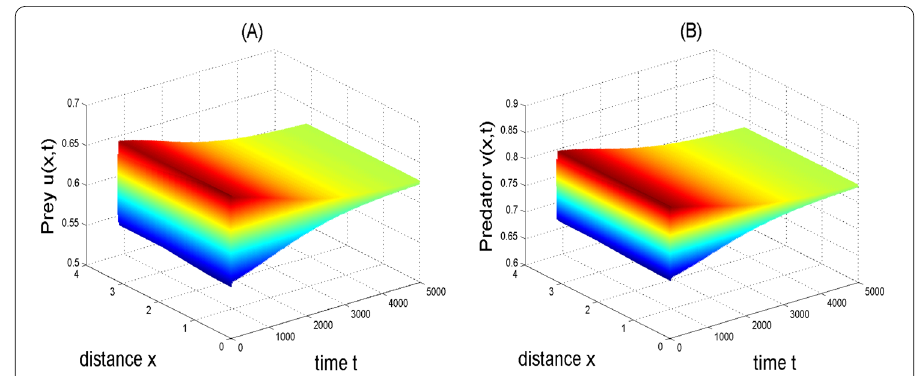
Figure 1 The positive equilibrium ( u ∗ , v ∗ ) = (0.6250,0.7813) of (1.2) is asymptotically stable when τ = 6.5 < 6.8222. Here we set parameter values d 1 = 0.2, d 2 = 1, δ = 2, α = 0.05, β = 0.3, h = 0.8, c = 0.1 and the initial value ( u ( x ,0), v ( x ,0)) = (0.62 + 0.005cos x ,0.78 + 0.005cos x